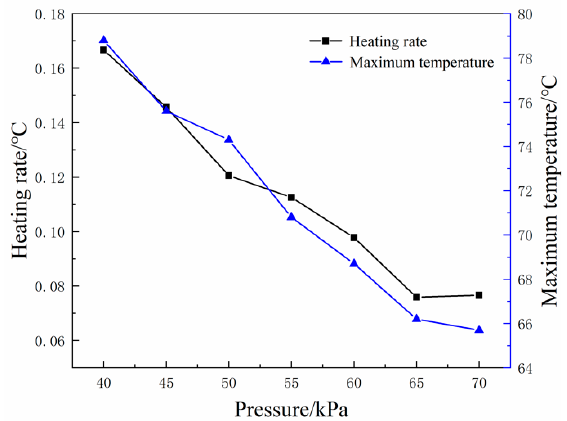
Figure 13. Comparison of heating rate and maximum temperature at different air pressures.